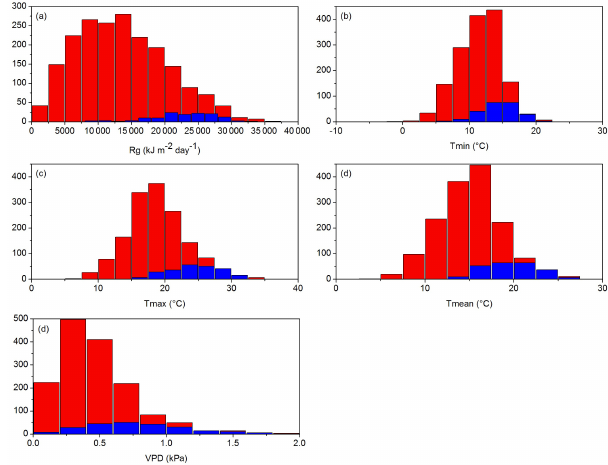
Figure 6. Histograms of the meteorological variables for the train- ing dataset (red) and the high O 3 uptake dataset (blue). The subplots represent global radiation R g (a) , minimum temperature T min (b) , maximum temperature T max (c) , mean temperature T mean (d) , and vapour pressure deficit VPD (e) . Table 2. Performance statistics for the multiplicative stomatal model: mean bias (MB), relative mean error (RME), systematic and unsystematic root mean square error (RMSE s / u ) , Willmott’s index of agreement ( d ), model efficiency (ME), and the coefficient of de- termination ( R 2 ). Statistics Parameterisation